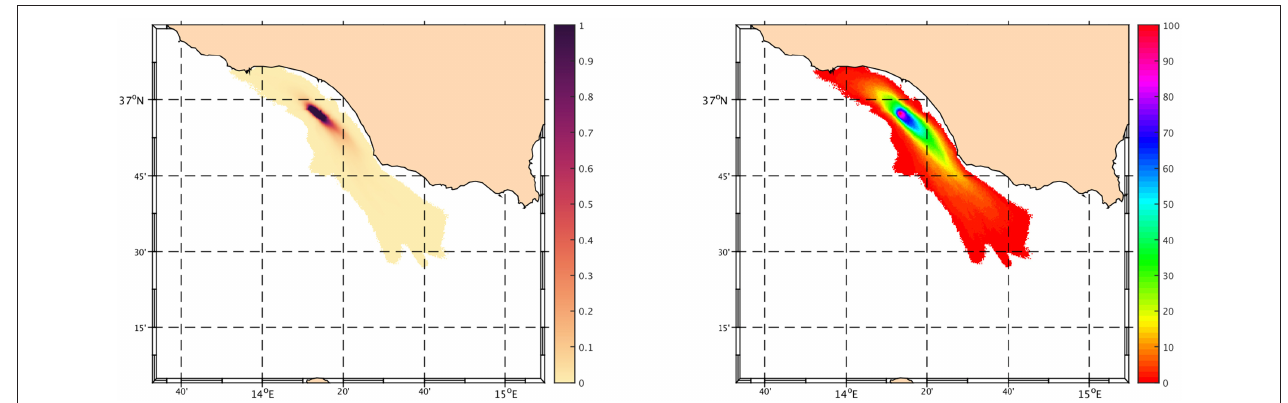
FIGURE 4 | Perla platform, Sicily Channel. (Left) 48 h Hazard Index, HI; (Right) 48 h Occurrence Index, OI.